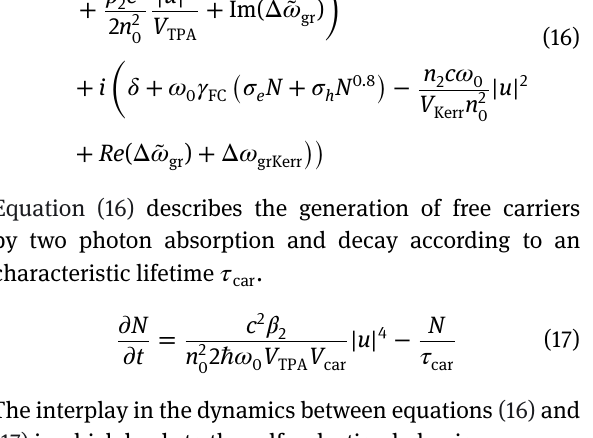
= 1550 nm, 0 = e 2 ∕ (4 ℏ 0